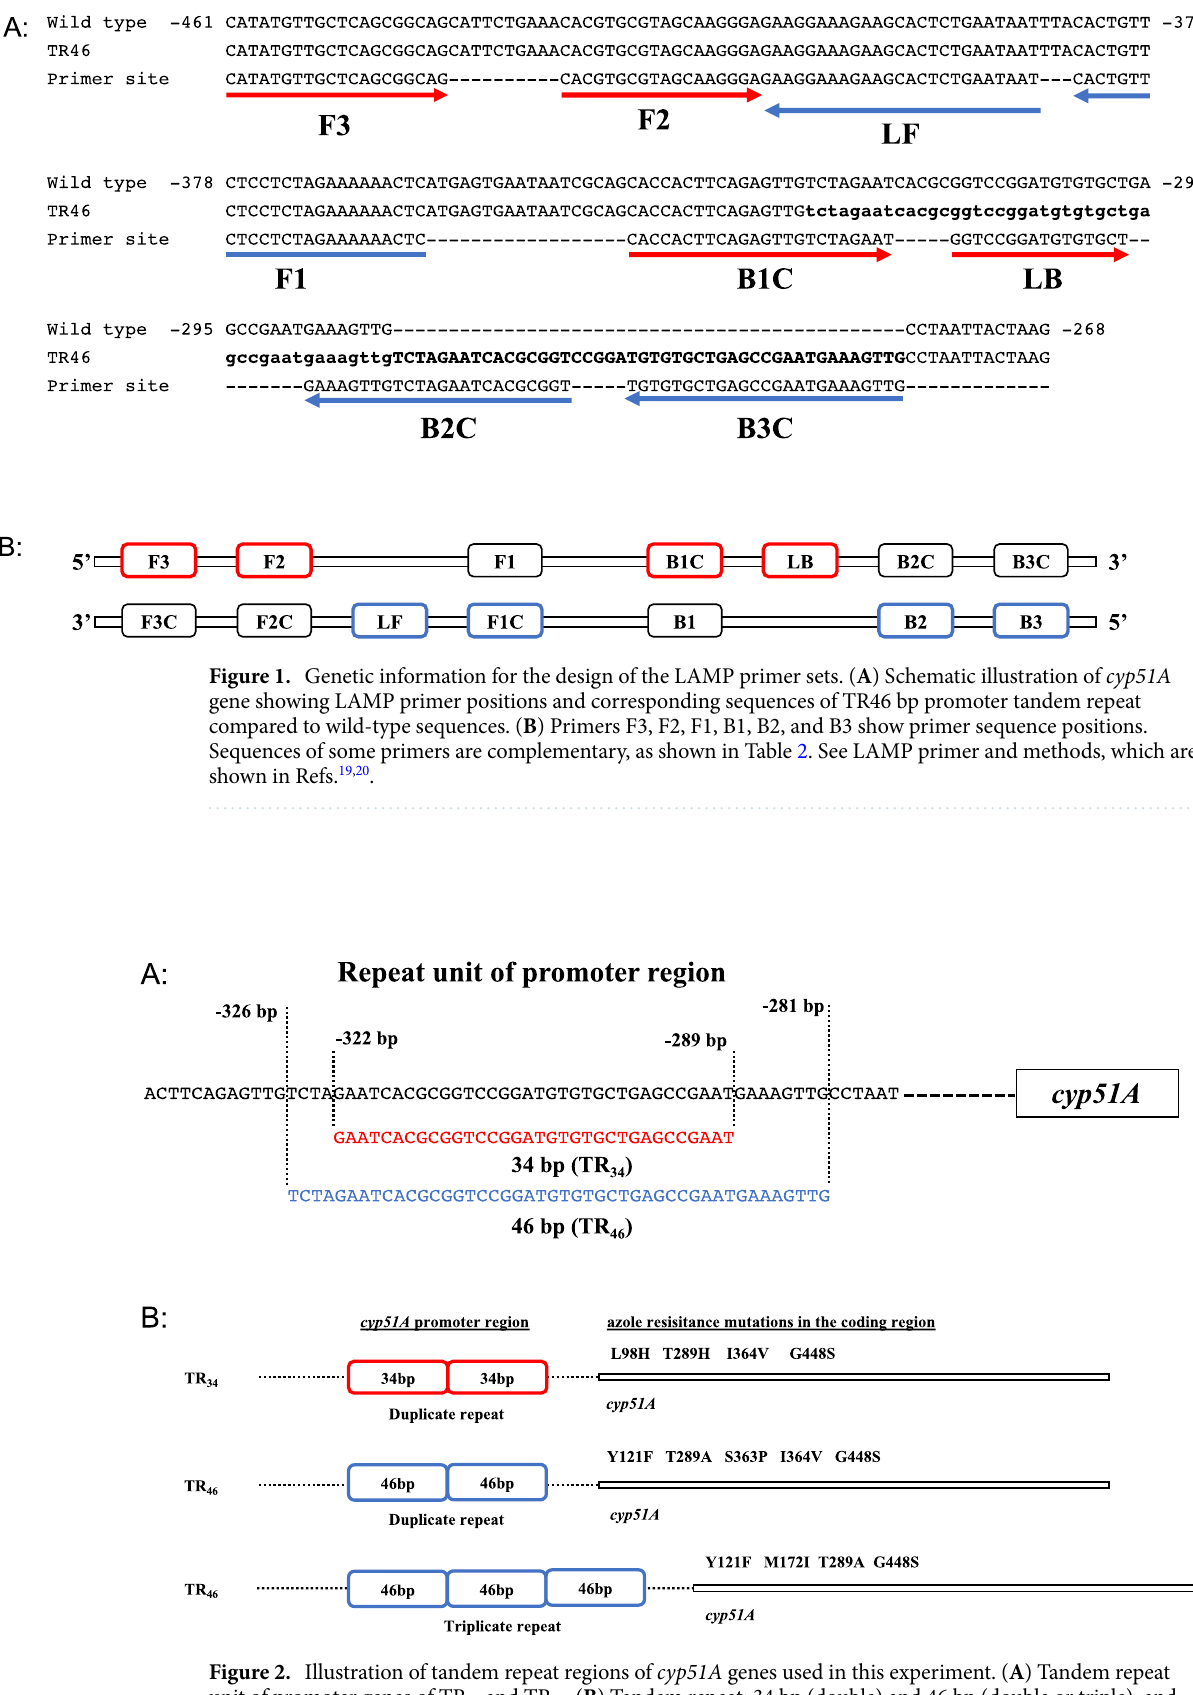
Figure 2. Illustration of tandem repeat regions of cyp51A genes used in this experiment. ( A ) Tandem repeat unit of promoter genes of TR 34 and TR 46 . ( B ) Tandem repeat: 34 bp (double) and 46 bp (double or triple), and cyp51A gene associated point mutation